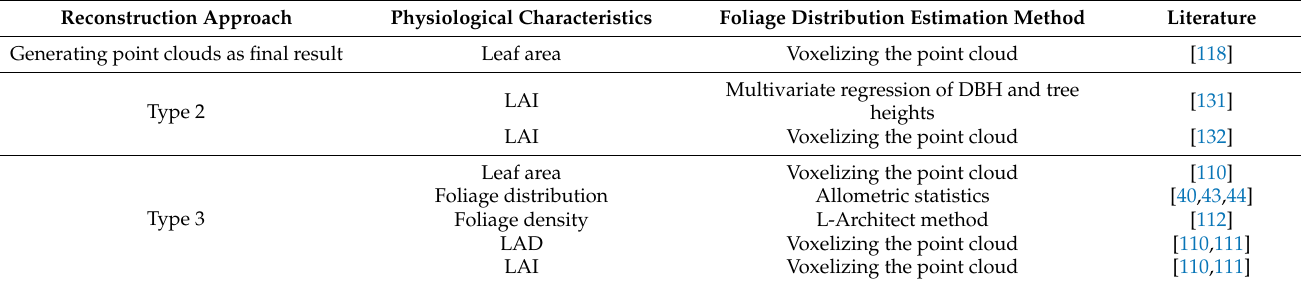
Table 11. Literature estimating foliage distribution during tree